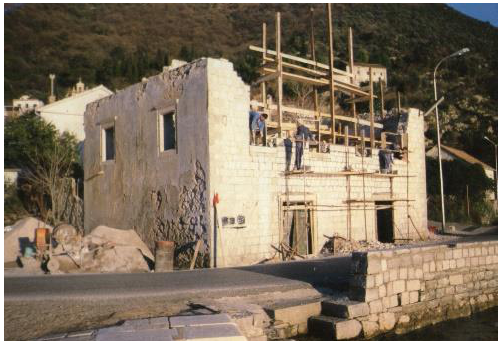
Figure 29. Captain’s house dating from 1842, before and at the beginning of reconstruction.